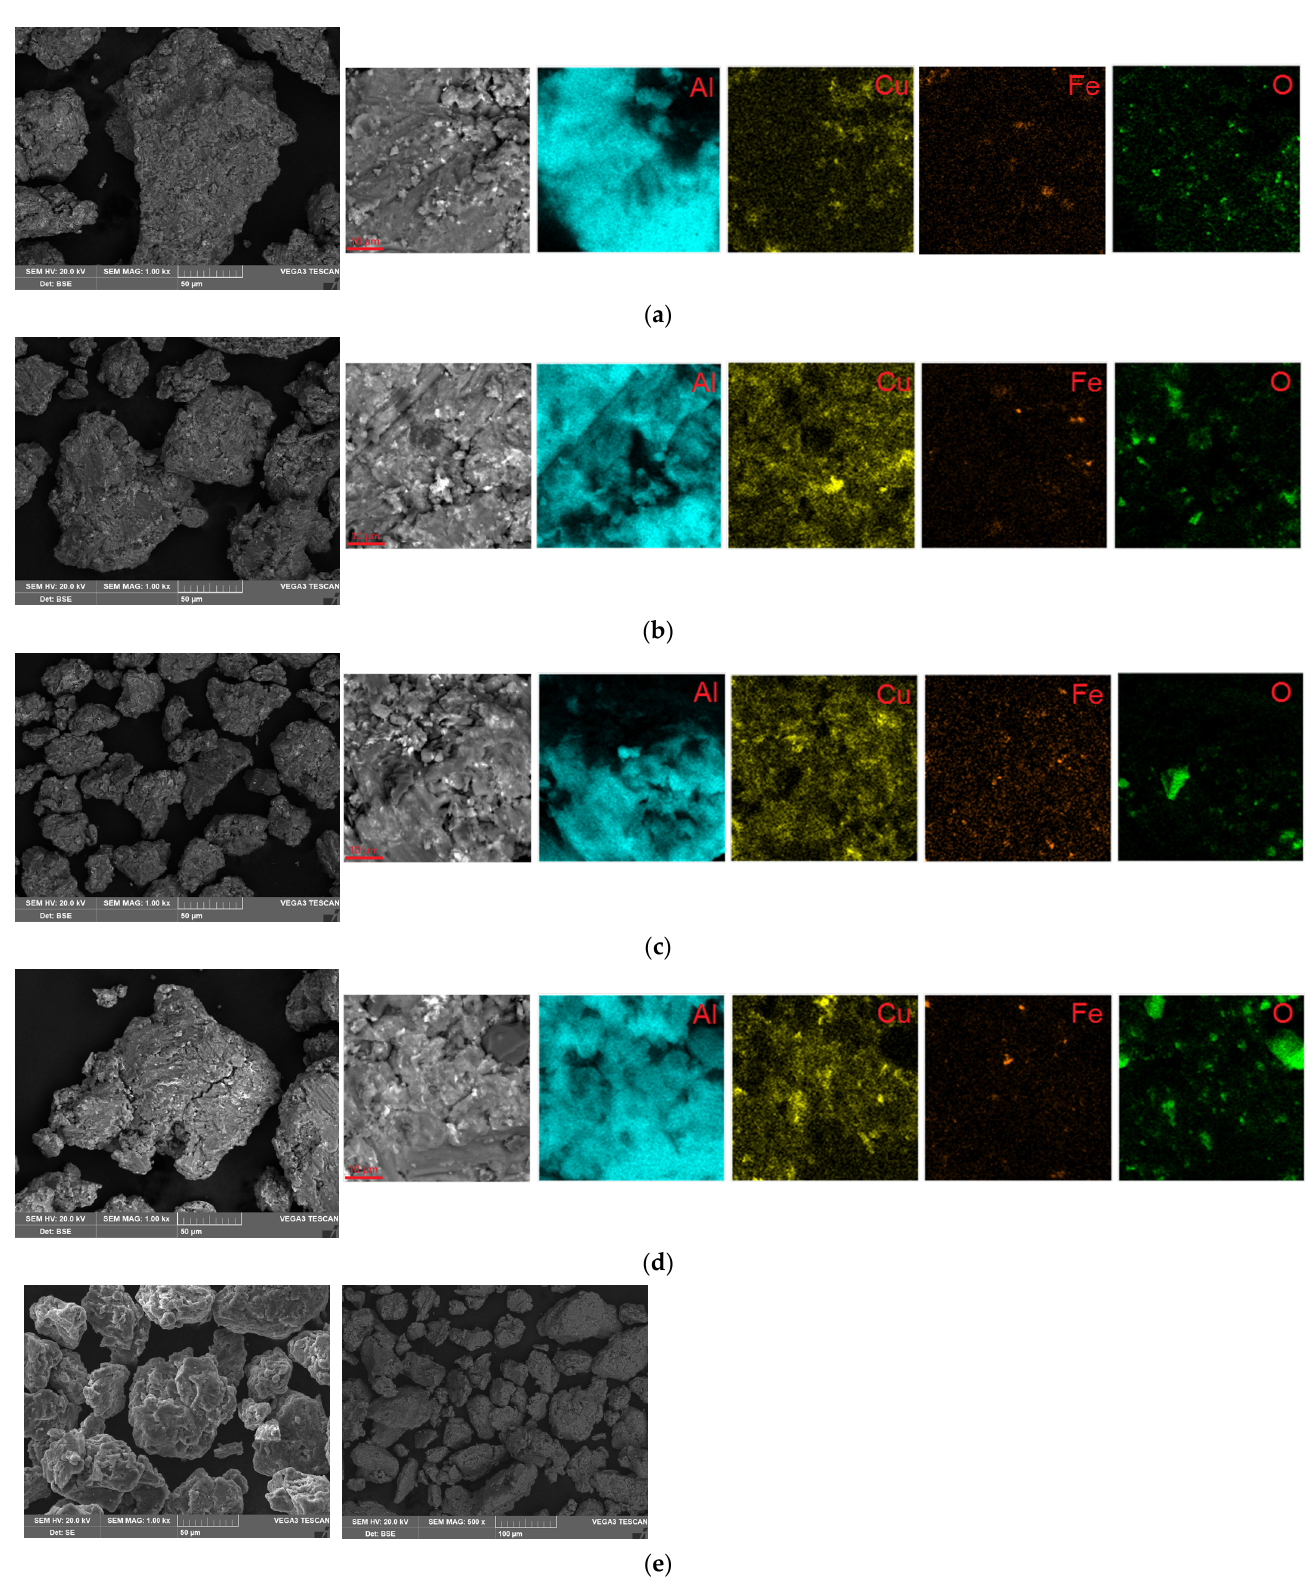
Figure 3. SEM images and the corresponding EDX element distribution maps for different ball milled samples: ( a ) 50–100 nm copper powder; ( b ) 1–19 μ m copper powder; ( c ) 50–70 μ m copper powder; ( d ) 150–250 μ m copper powder; ( e ) without copper powder.